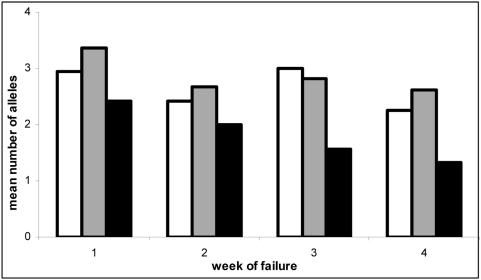
Comparison of Multiplicity of Infection (MoI) at enrolment and at day of failure and the mean MoI in cases of recrudescence by week of failure.LEGEND: 67 symptomatic treatment failures cases were successfully analysed by both MSP2 and pfPK2 and were sorted according to week of failure post treatment. White bars show the mean multiplicity of infection (MoI) at enrolment. Grey bars show the MoI on the day of treatment failure. Black bars show the mean number of matching alleles in the pre and post treatment sample of each patient (N = 49 after exclusion of those defined as new infections).